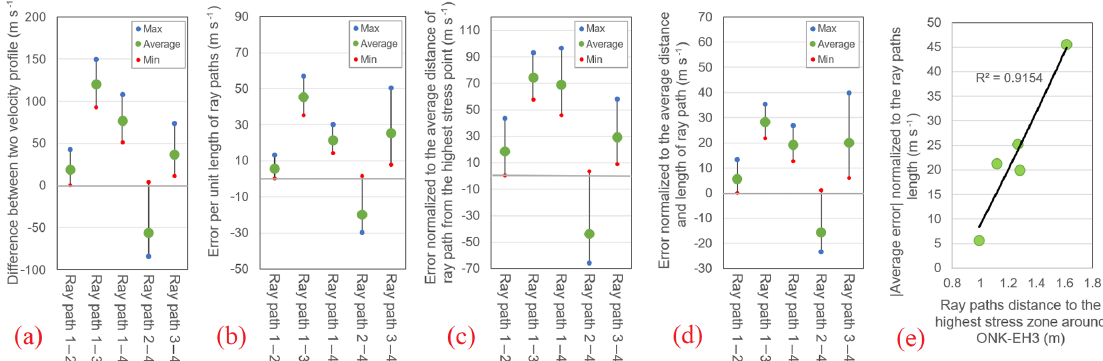
Figure 13. Error plots as the difference between two velocity profiles of each ray path. (a) Non-normalized; (b) normalized to the length of ray paths (c) normalized to the averaged grid points distance located on each ray path from the highest stress zone around the experimental hole; (d) normalized to both length and average distance of ray paths; (e) the average error normalized to the ray path length as a function of the ray path distance (average distance of grid points) to the highest stress zone around